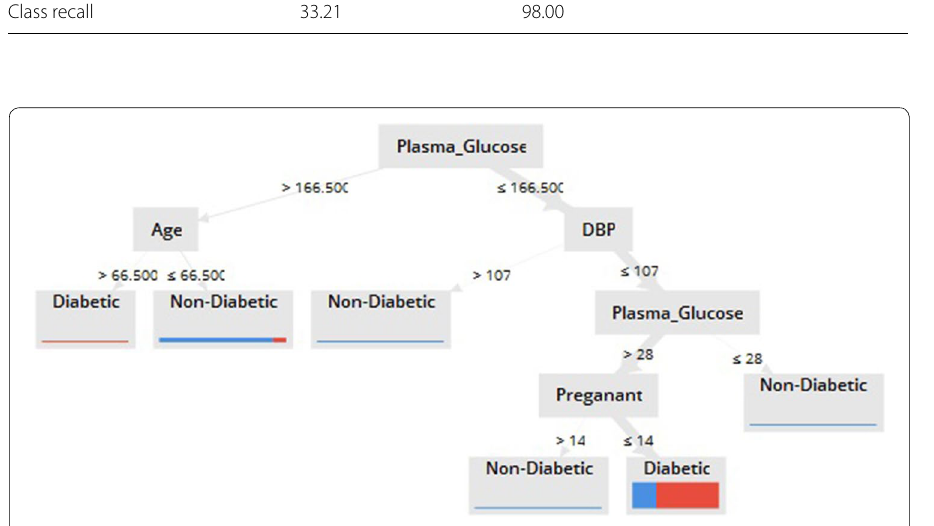
Fig. 7 A tree structure generated for random forest